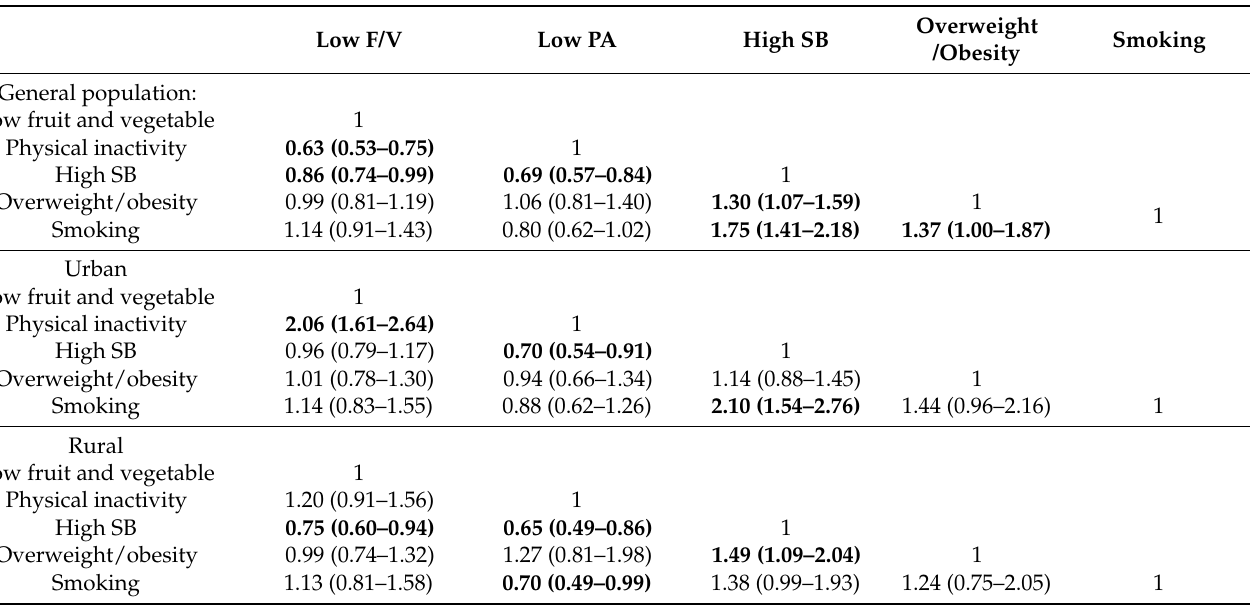
Table 5. Odds ratio (95% CI) for the co-occurrence of two lifestyle behavioral risk factors in Algerian adolescents aged 11–16 years, stratified by location, Global School-based Student Health Survey, Algeria, 2011. Low F/V Low PA High SB